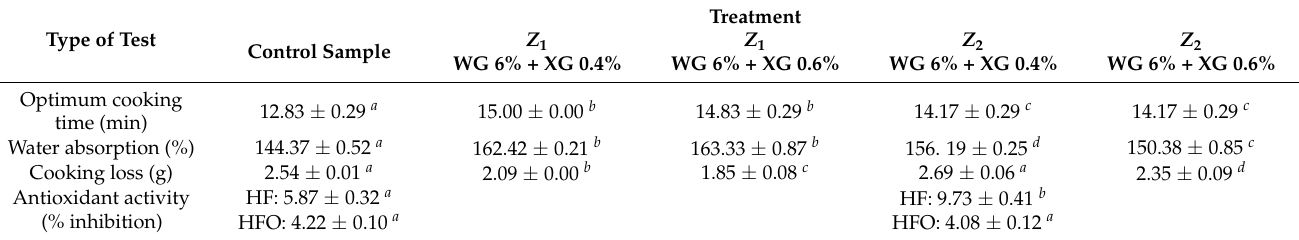
Table 3. Evaluation of noodles quality: cooking properties, antioxidant activity and